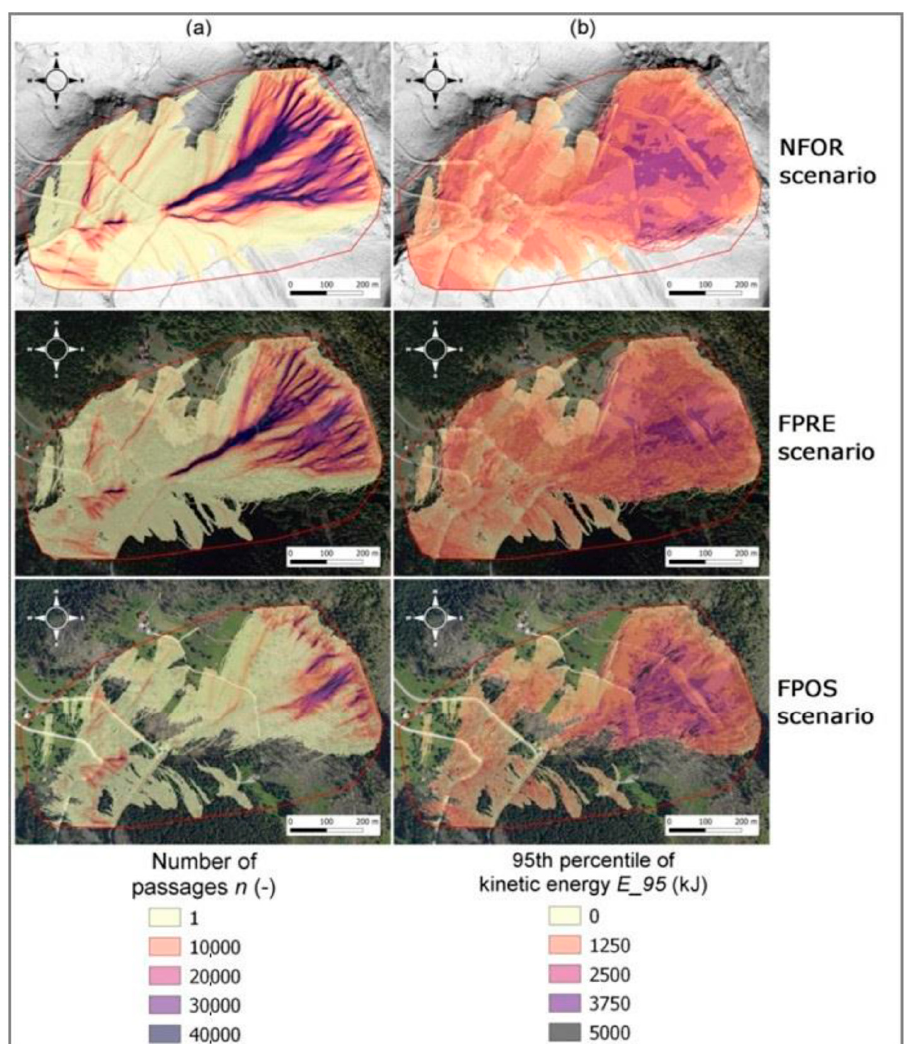
Figure 6. Output of Rockyfor3D simulations. In the first row the simulation in a ‘no forest’ scenario, in the second row the simulation in a ‘with forest’ scenario, in the third row the simulation in a ‘post windstorm’ scenario. Column ( a ) represents the number of passages of rockfall activity while column ( b ) represents the 95th percentile of the kinetic energy of falling blocks. The red line delimits the computational domain boundary of the numerical